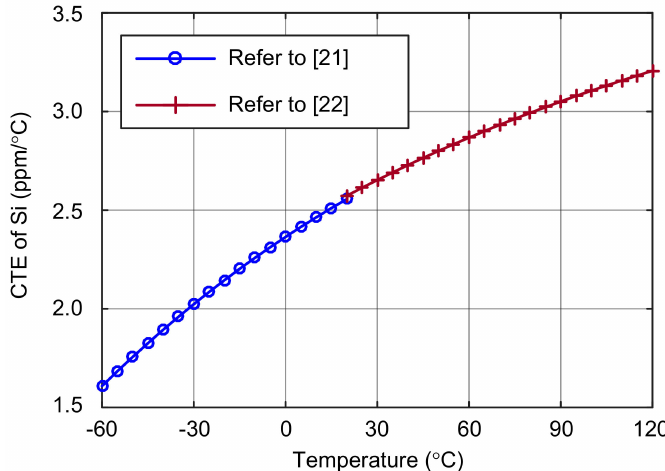
Figure 2. The coefficient of thermal expansion of